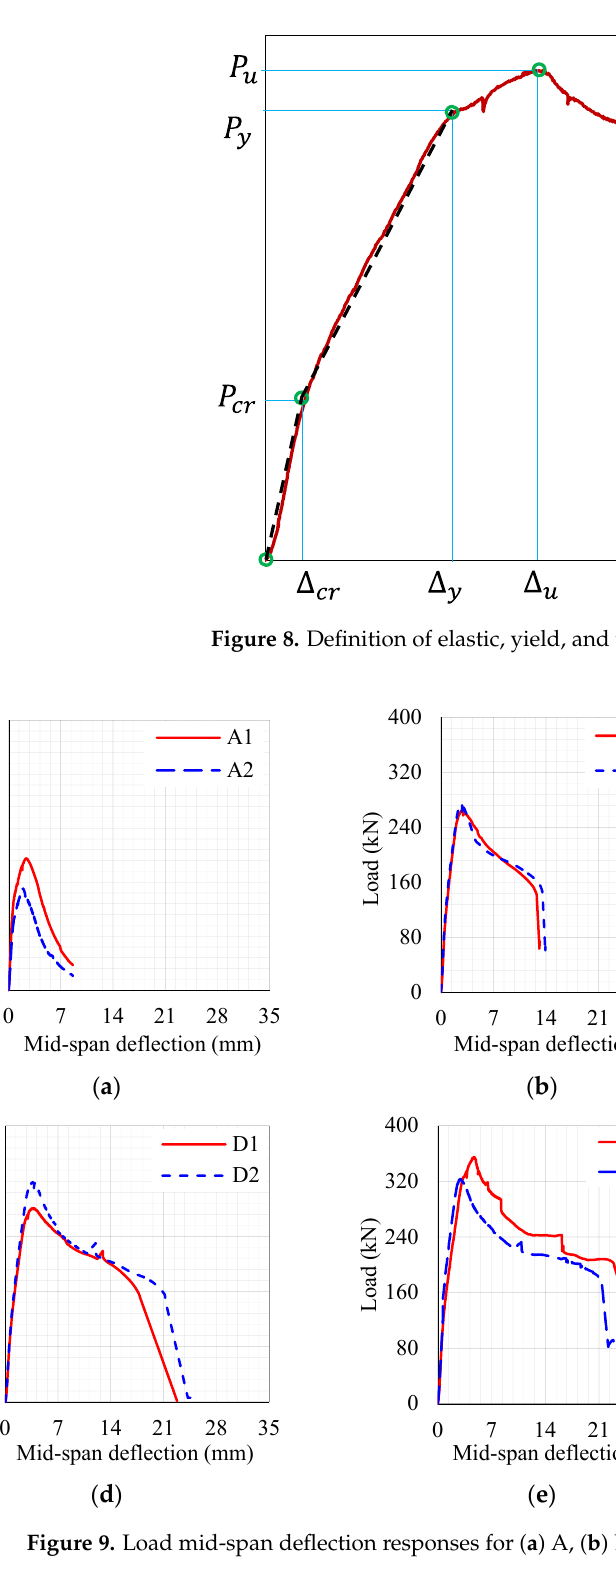
Figure 7. Modes of failure for the UHPC beams.